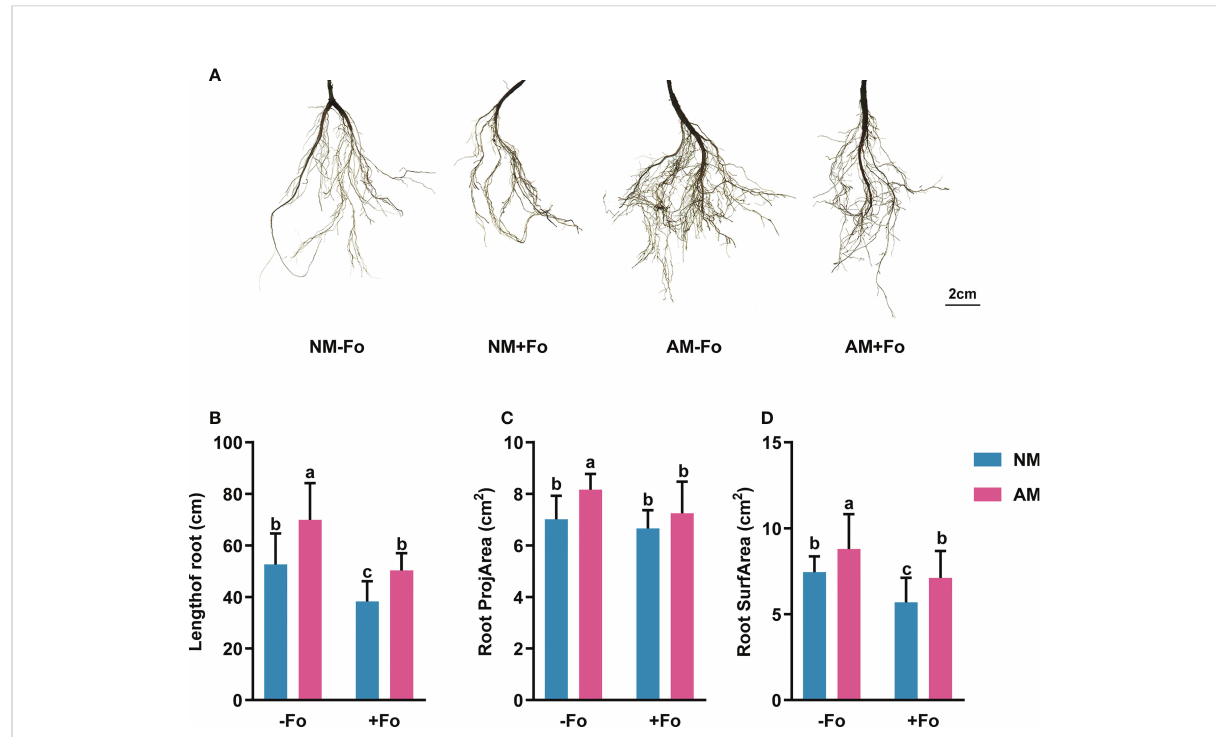
FIGURE 2 Root morphology of S. miltiorrhiza in the four treatments. (A) Root scans of S. miltiorrhiza in AM+Fo treatment and NM+Fo treatment. Length of root (B) , root projArea (C) , and root surfArea (D) of S. miltiorrhiza 30 days after pathogen inoculation. Four treatments included: (1) NM-Fo: non- mycorrhizal S. miltiorrhiza inoculated with heat-killed pathogen inoculation; (2) NM+Fo: non-mycorrhizal S. miltiorrhiza inoculated with pathogen; (3) AM-Fo: mycorrhizal S. miltiorrhiza inoculated with heat-killed pathogen; (4) AM+Fo: mycorrhizal S. miltiorrhiza inoculated with pathogen. Values are means ± SD from four sets of independent experiments with 30 pots per treatment for each set of experiments. Different lowercase letters indicate signi fi cant differences between different treatments according to two-way ANOVA followed by Tukey ’ s test for multiple comparisons ( P <